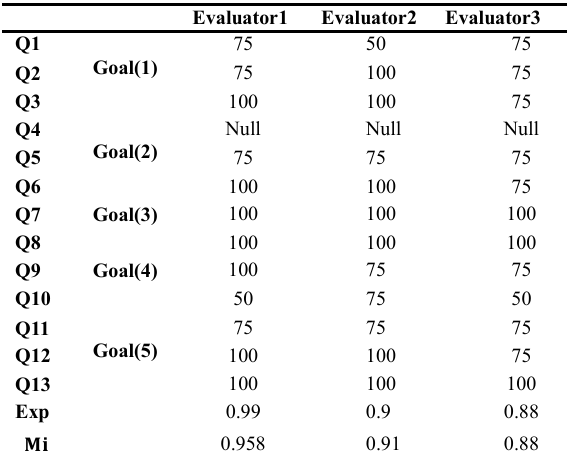
Table 1.The scores assigned to 13 questions and variable LExp by 3